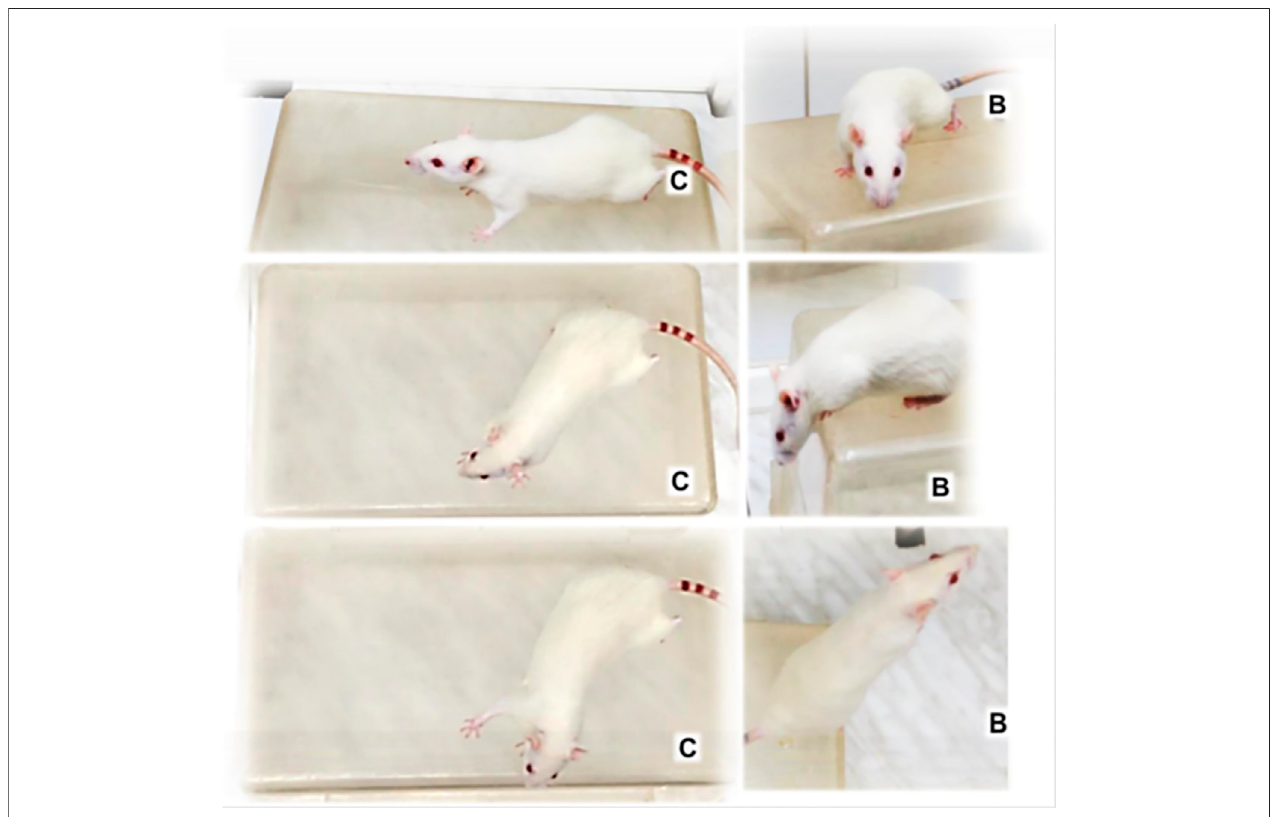
FIGURE8| Illustrative animal behavior daysafter retrobulbarapplication ofL-NAMEwhen mountedon anelevated surface(50 cmlong,20 cmwidth, 30 cmhigh) and fi lmed for 1 minute. Regularly, rats maintained the initial position fi rmly standing on to the surface with posterior legs, almost ― frozen (cid:1) , with only limited movements around [control (C)], unless treated with BPC 157 (B) showing no freezing behavior, but quick exploration, and escaping from the elevated surface.